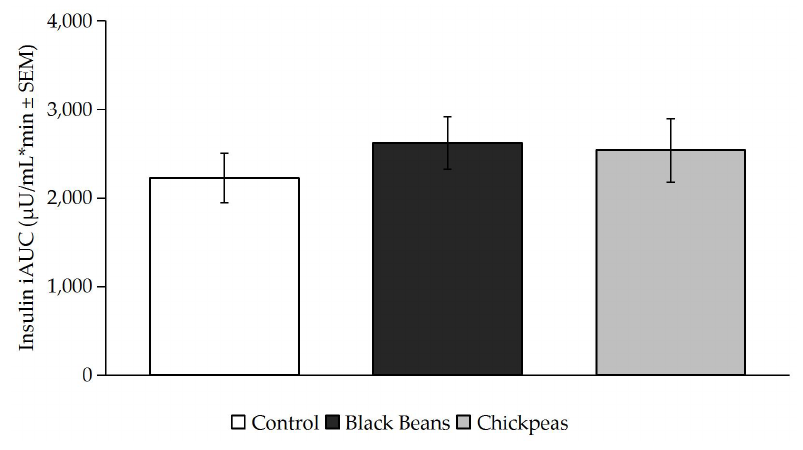
Figure 4. Insulin iAUC was not significantly different by treatment ( p >0.05). Bars denote mean insulin iAUC values and error bars denote standard error of means. iAUC values and error bars denote standard error of